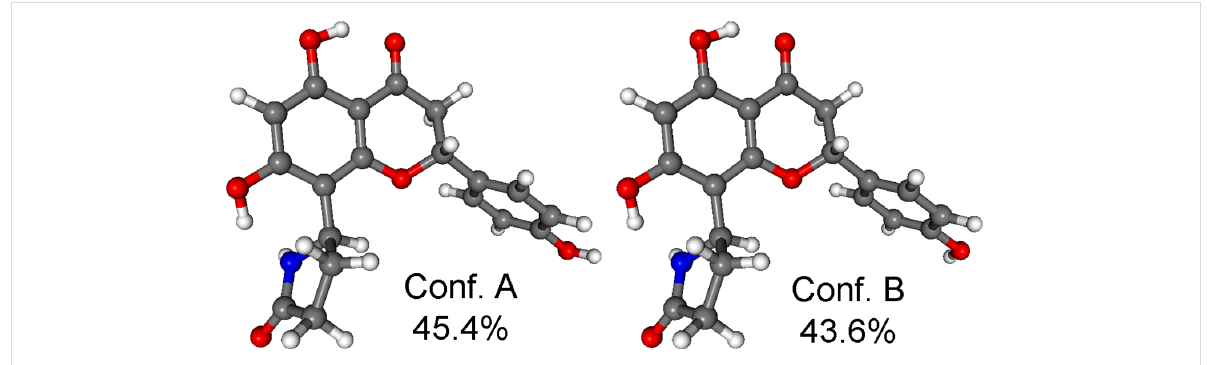
Figure 10: Structure and population of the low-energy CAM-B3LYP/TZVP PCM/MeCN conformers (>2%) of (2 R ,5’’ R )- 3c .